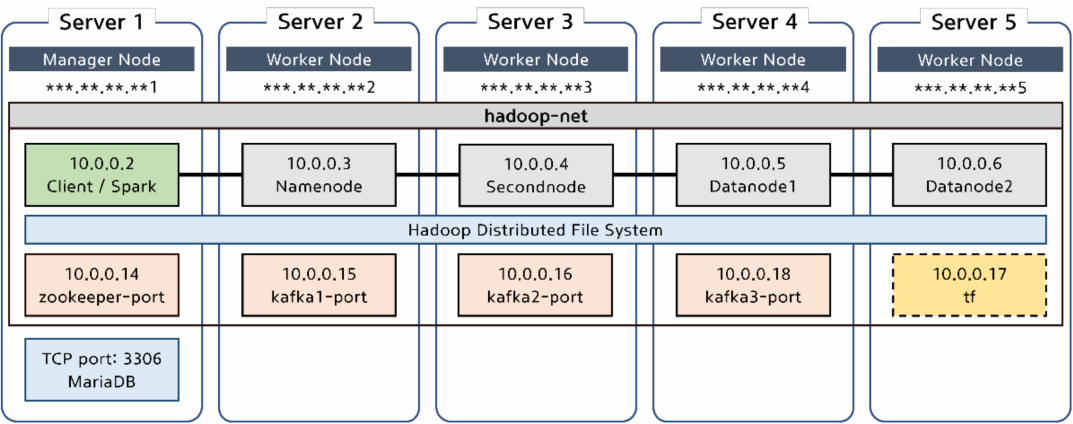
Figure 6. Hadoop-based big data platform consisting of docker